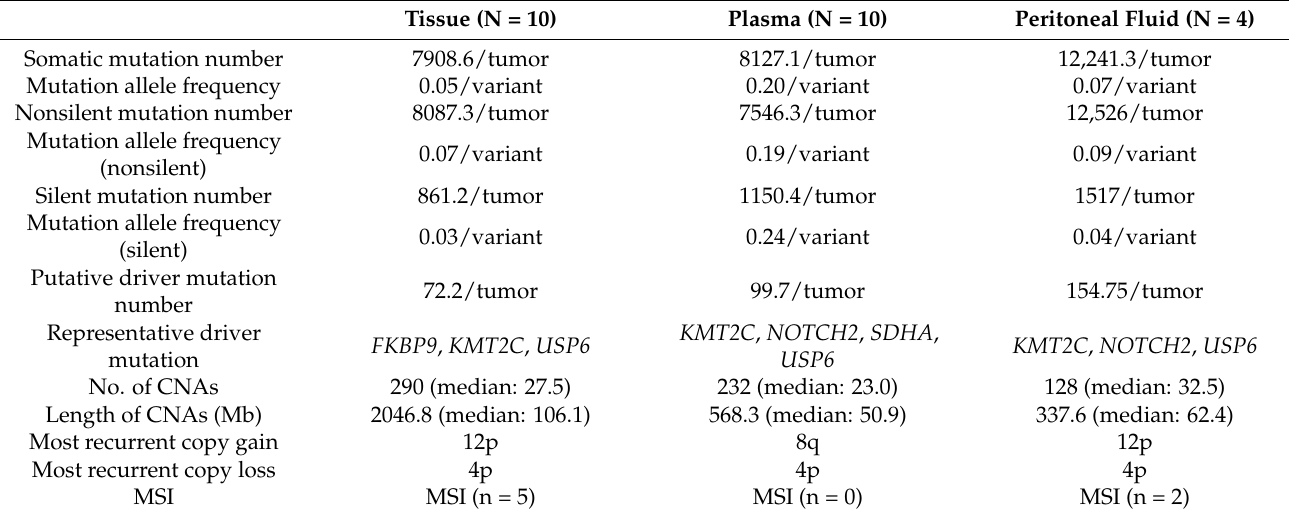
Table 3. Summary of comparison of the data from tissue, plasma, and peritoneal fluid samples for the EC